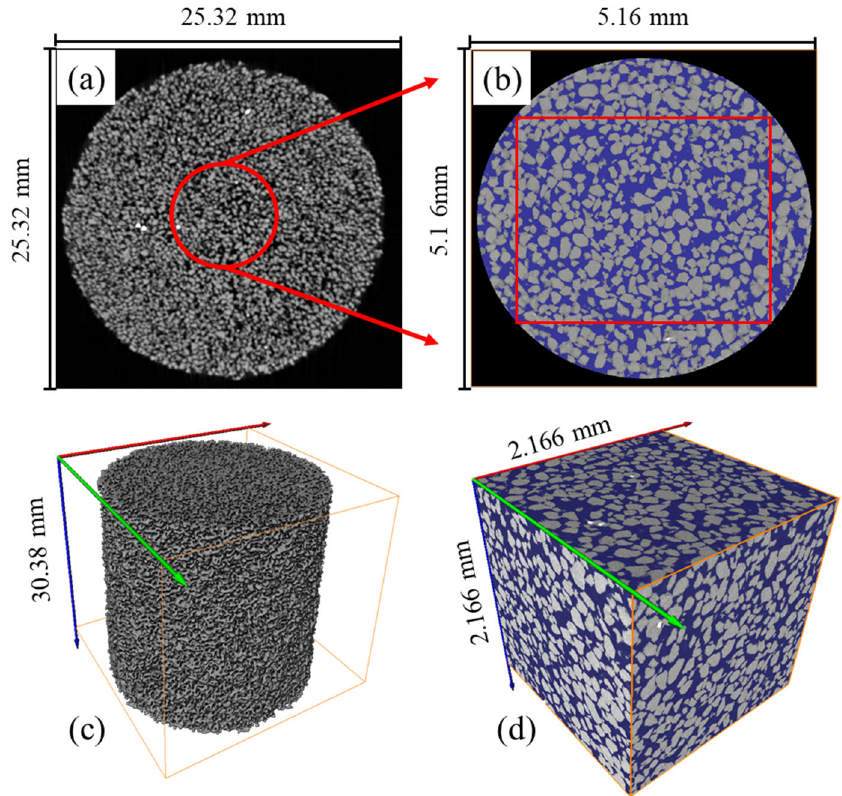
Figure 16. Pore structure characterization of the 3DP rocks via micro ‐ CT imaging under large view mode ( a,c ) and high ‐ resolution mode ( b,d ); the sand grain and pore phase are shown in gray and blue color, respectively.